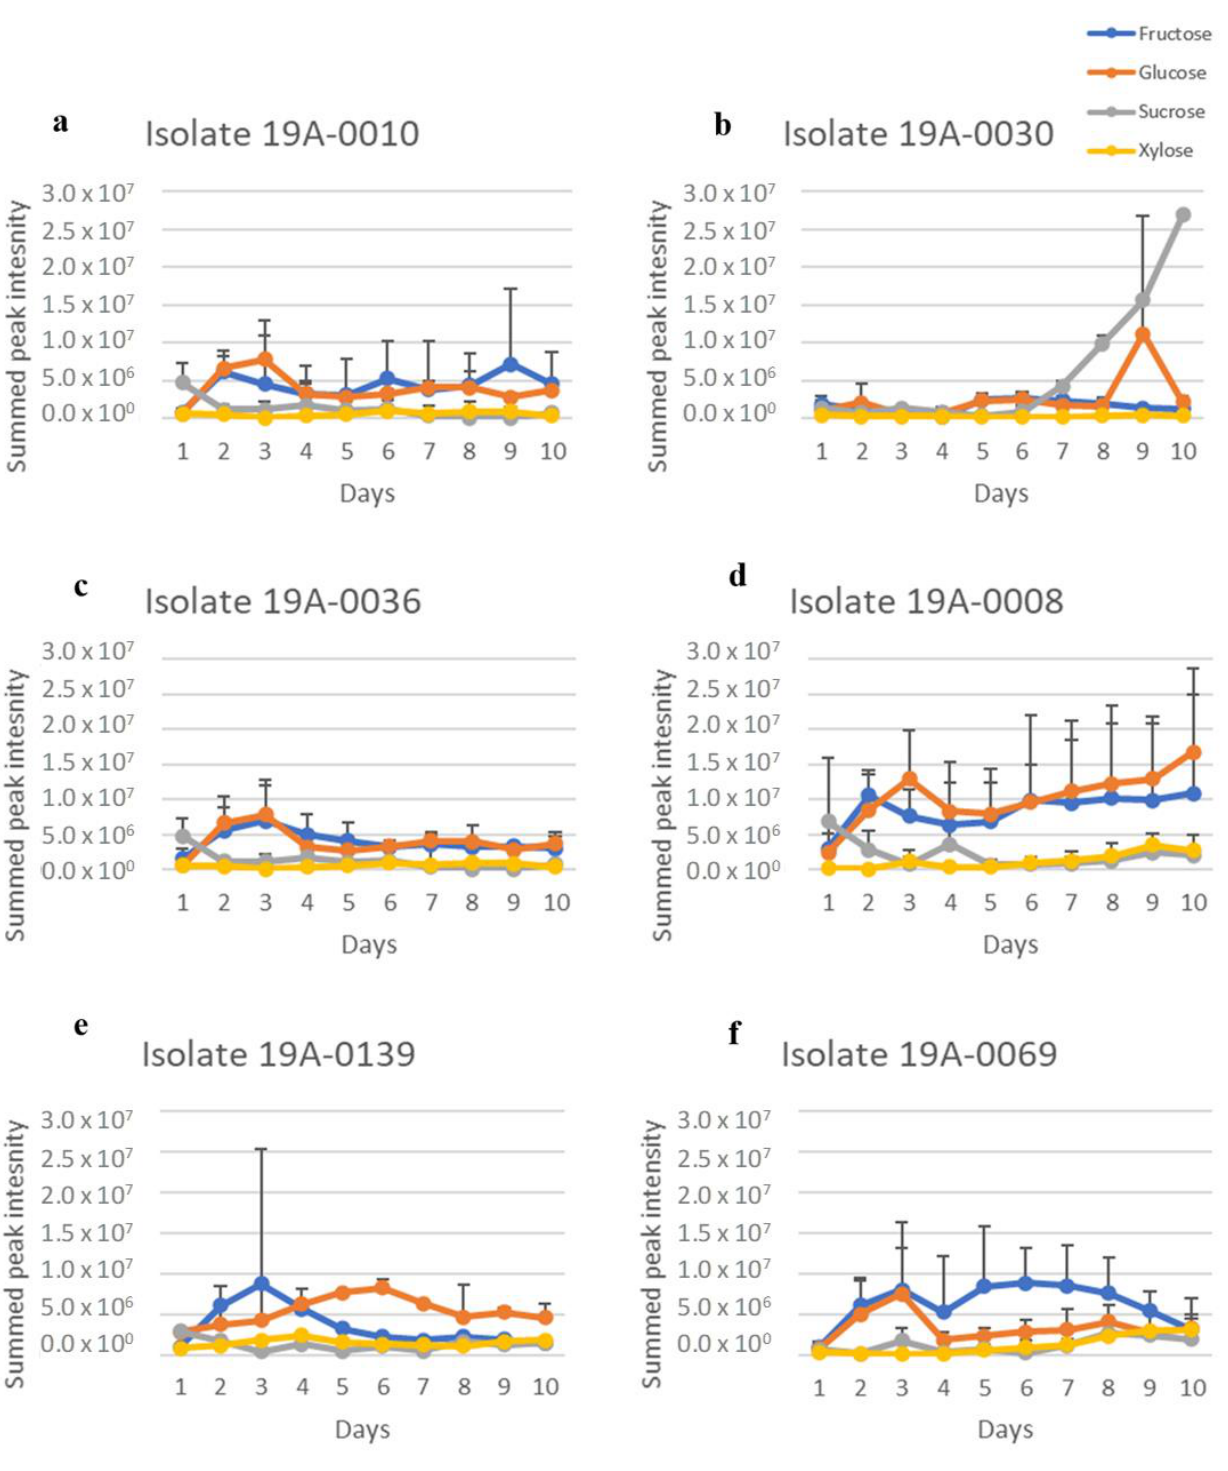
Figure 7. Fumaric acid production of R. stolonifer isolates in the presence of glucose, fructose, sucrose, or xylose, along with NH 4 (SO 4 ) 2 as a nitrogen source. Data presented are the relative concentration of fumaric acid (as determined from NMR) with standard deviation (error bars), n = 3. ( a ) Isolate 19A – 0010, ( b ) isolate 19A – 0030, ( c ) isolate 19A – 0036, ( d ) isolate 19A – 0008, ( e ) isolate 19A – 0139, ( f ) isolate 19A – 0069.